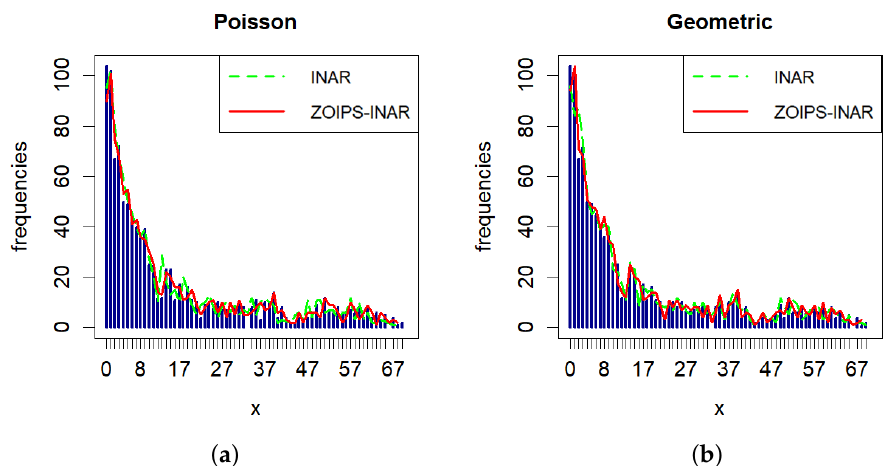
Figure 6. Frequency distributions of the observed time series and data fitted by INAR(1) and ZOIPS- INAR(1) models: ( a ) Poisson-distributed innovations; ( b ) geometric-distributed